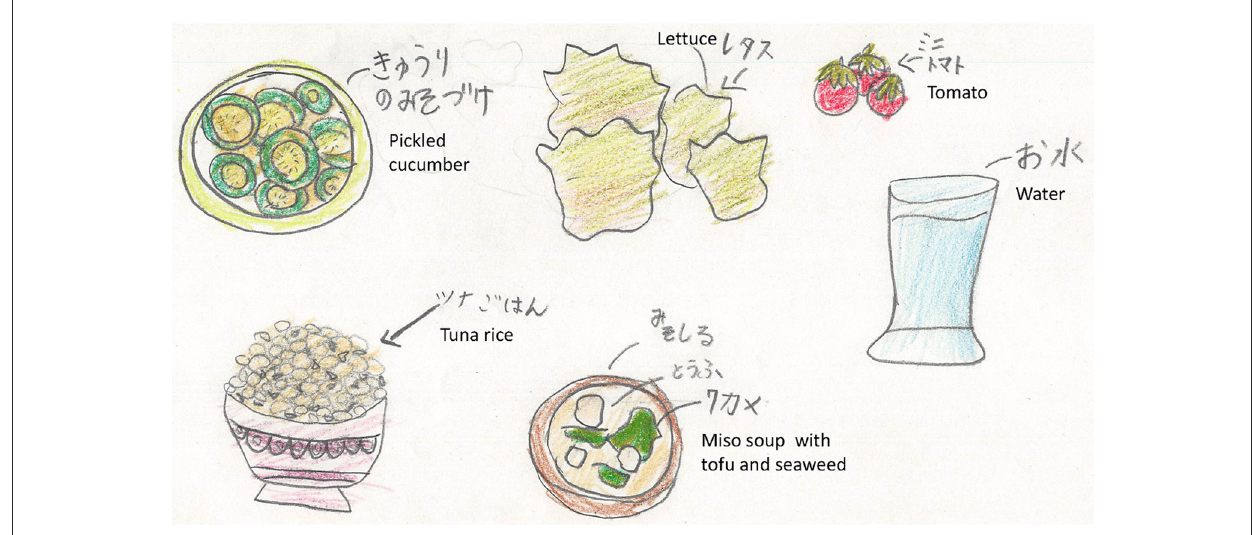
FIGURE4 Drawing of a typical Japanese lunch with pickled cucumber as a side